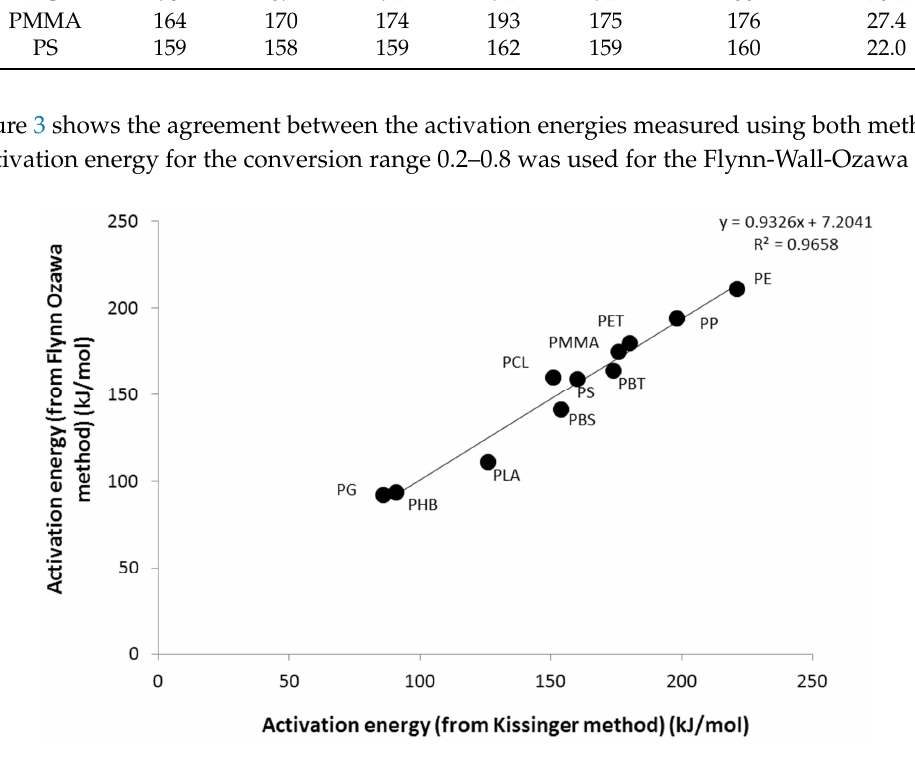
Figure 3. Comparison of activation energy values obtained from the Kissinger and Figure 3 – Comparison of activation energy values obtained from Kissinger and Flynn-Wall-Ozawa Flynn-Wall-Ozawa methods